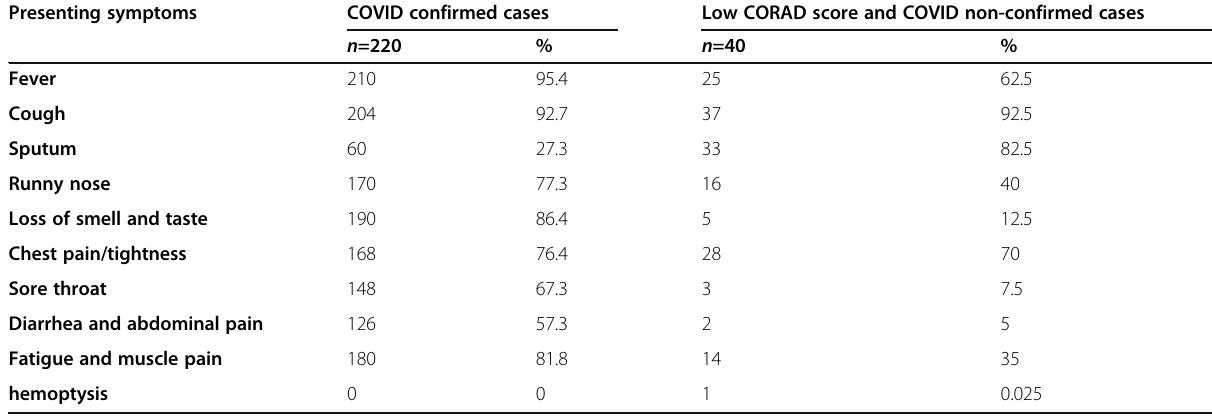
Table 2 Clinical presentation of the